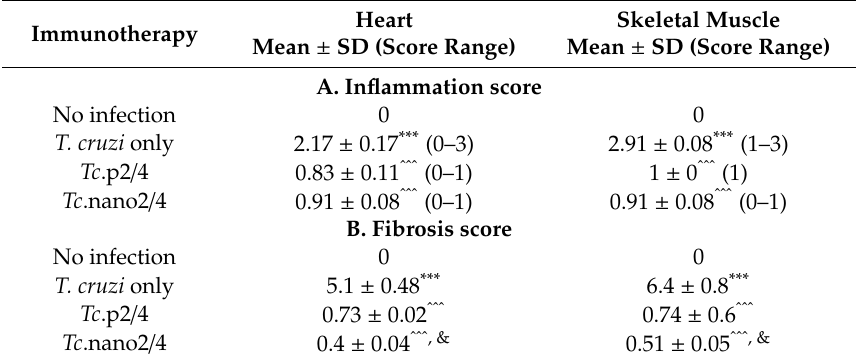
Table 1. Semi-quantitative scoring of tissue pathology in Chagas mice ( ±